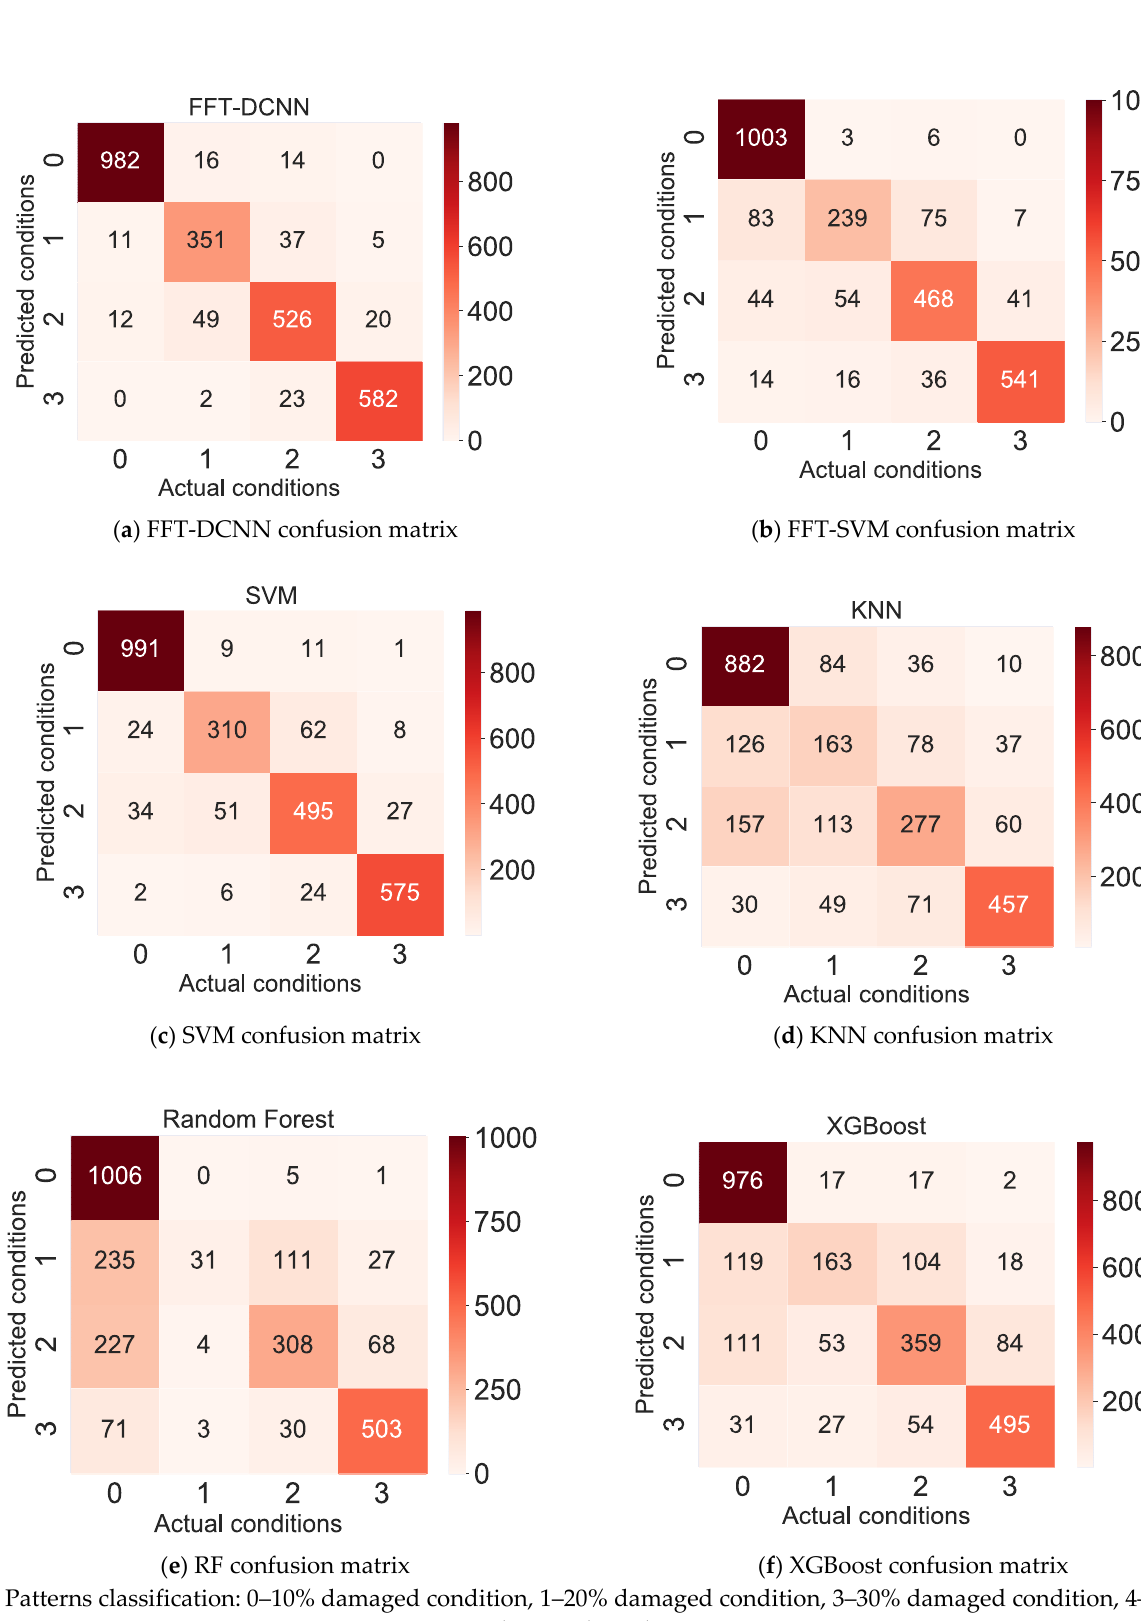
Figure 12. Confusion matrix between actual conditions and predicted conditions.